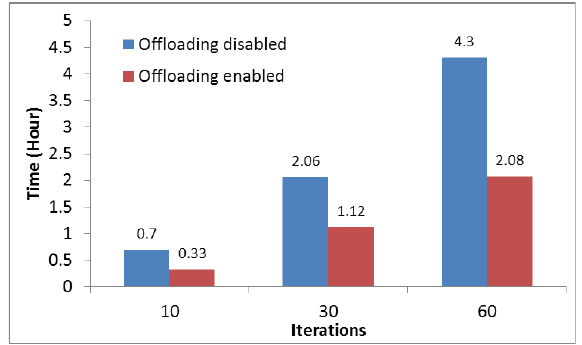
Figure 12: Execution time of AT on 208×44×46